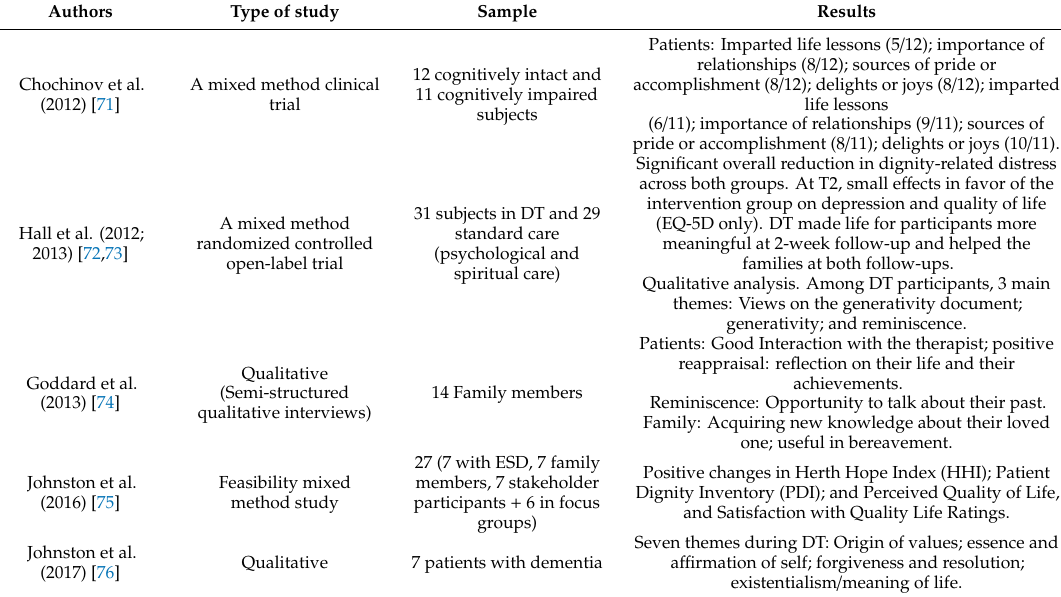
Table 3. Available studies applying DT in the elderly